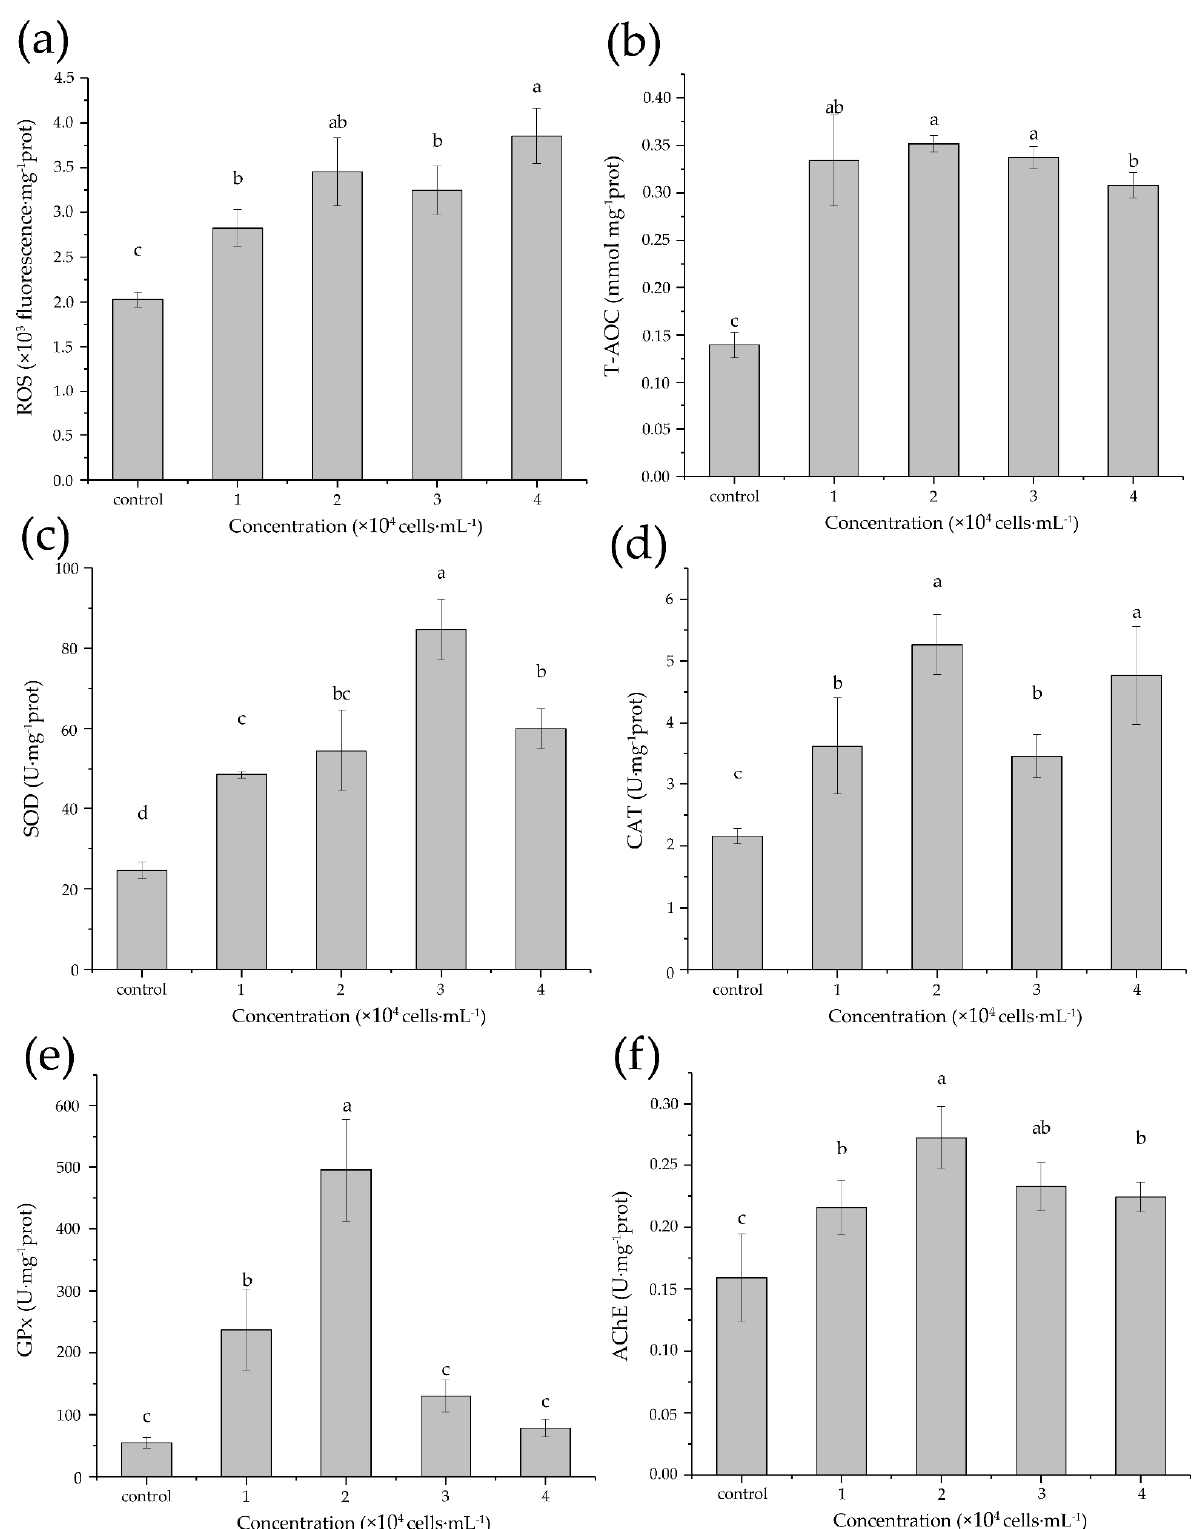
Figure 3. Effects of K. mikimotoi on biochemical parameters related to oxidative stress and neuro- transmitter in T. japonicus . ( a ) reactive oxygen species (ROS), ( b ) total antioxidant capacity (T-AOC), ( c ) superoxide dismutase (SOD), ( d ) catalase (CAT), ( e ) glutathione peroxidase (GPx), and ( f ) ace- tylcholinesterase (AChE). Different letters indicate a significant difference among groups at p < 0.05.